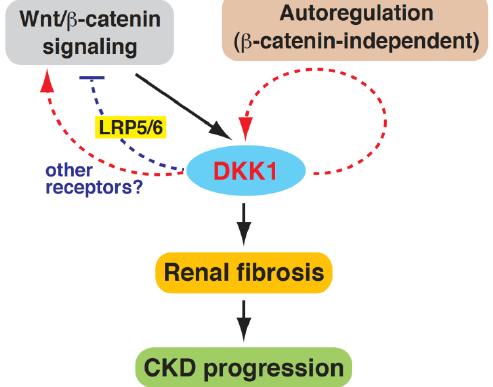
Figure 7. Proposed model of DKK1-mediated renal fibrosis. During renal injury, DKK1 can be ini- tially activated by the Wnt/ β -catenin signaling pathway. Subsequently, DKK1 may autoregulate its